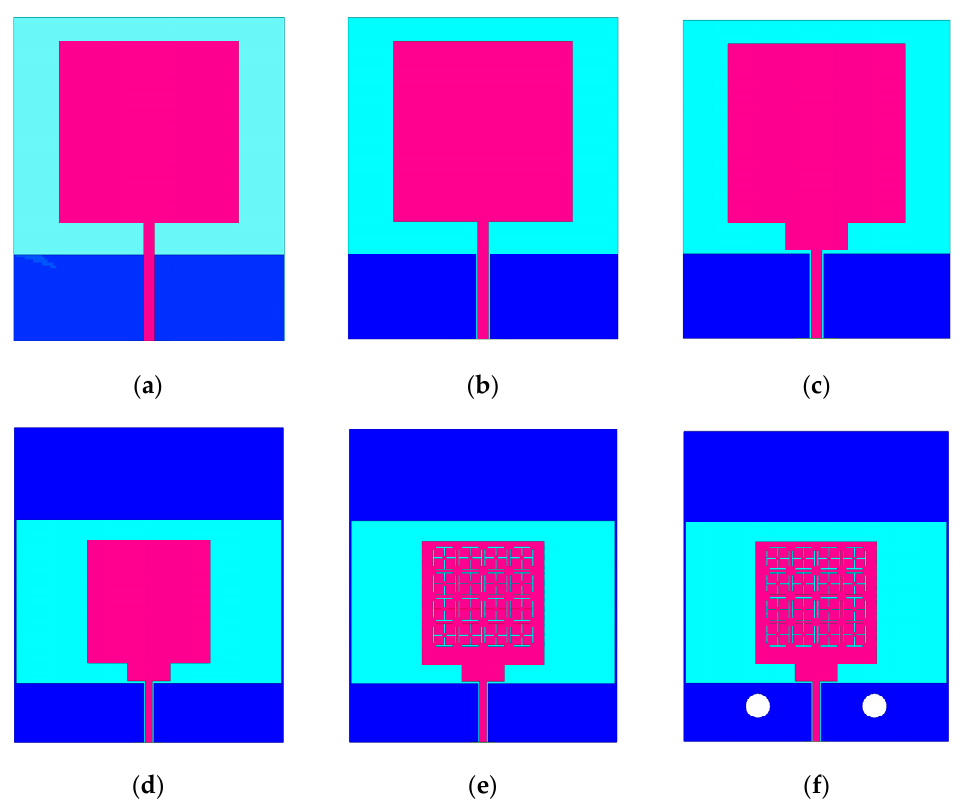
Figure 3. Design steps of UWB antenna: ( a ) Ref. Antenna; ( b ) first step; ( c ) second step; ( d ) third step; ( e ) Pro. Antenna; ( f ) perforated antenna model.